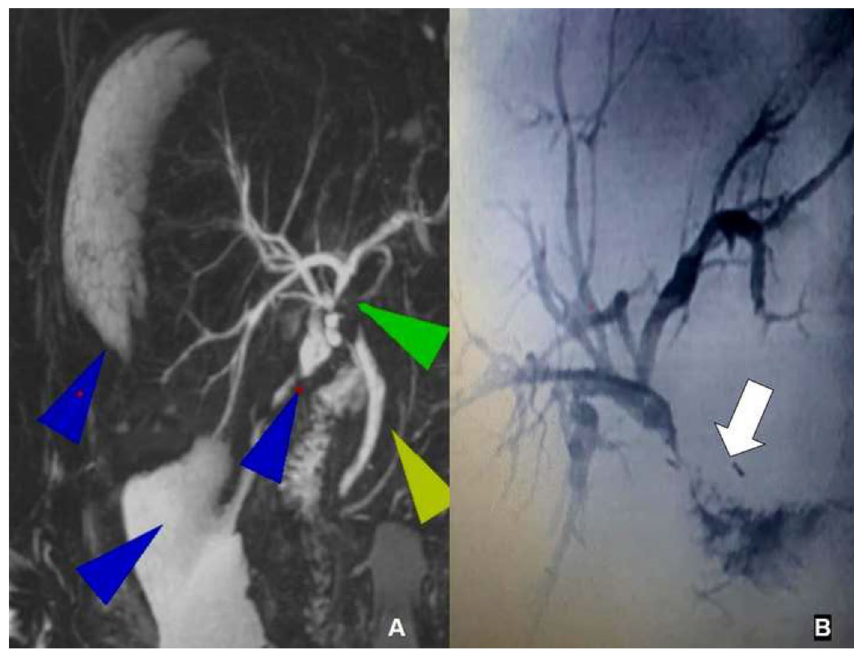
Fig. 6 3D-MRCP ( a ) post-cholecystectomy with interruption of the CHD at the biliary confluence “green arrowhead” yet still preserved communication between the right and left hepatic duct. This is associated with biliary leakage “blue arrowheads” at the CHD injury as well as at the subhepatic and sub-phrenic regions. Distal CBD “yellow arrowhead”. Strasberg Type E3; Bismuth-Corlette Type 3 hilar bile duct injury. PTC ( b ) demonstrates extraluminal contrast extravasation at the level of hilar biliary confluence “white arrow”